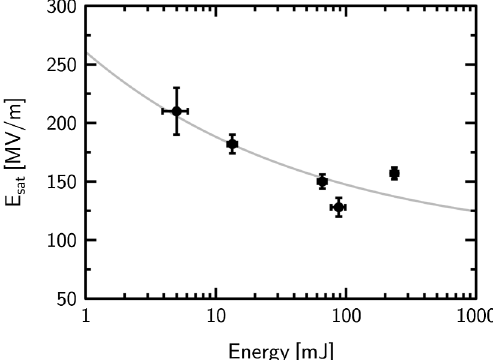
FIG. 11. Correlation between DC and rf energy dependency. The DC measurement points have been fitted to the behavior (cid:2) W (cid:3) 1 = 4 that is expected based on rf E sat